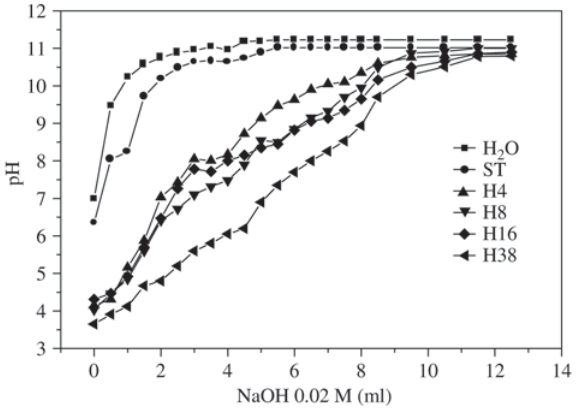
Figure 5. Potentiometric titration of the carbons C/HNO NaOH (0.02 M).